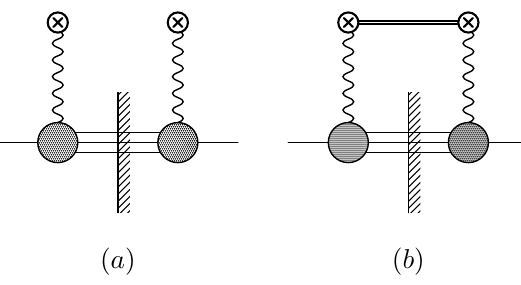
Figure 1 . Matrix element of the PDF operator in a proton state for (a) photon and Z PDFs, and (b) W PDFs, where the U(1) em Wilson line is shown as a double line. The (cid:10) vertex is the (cid:12)eld-strength tensor and the bottom part of the graphs is the hadronic tensor W (cid:22)(cid:23) ( p; q